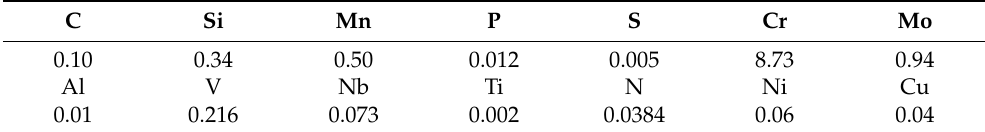
Table 1. Chemical composition of the investigated steel (weight percentage,